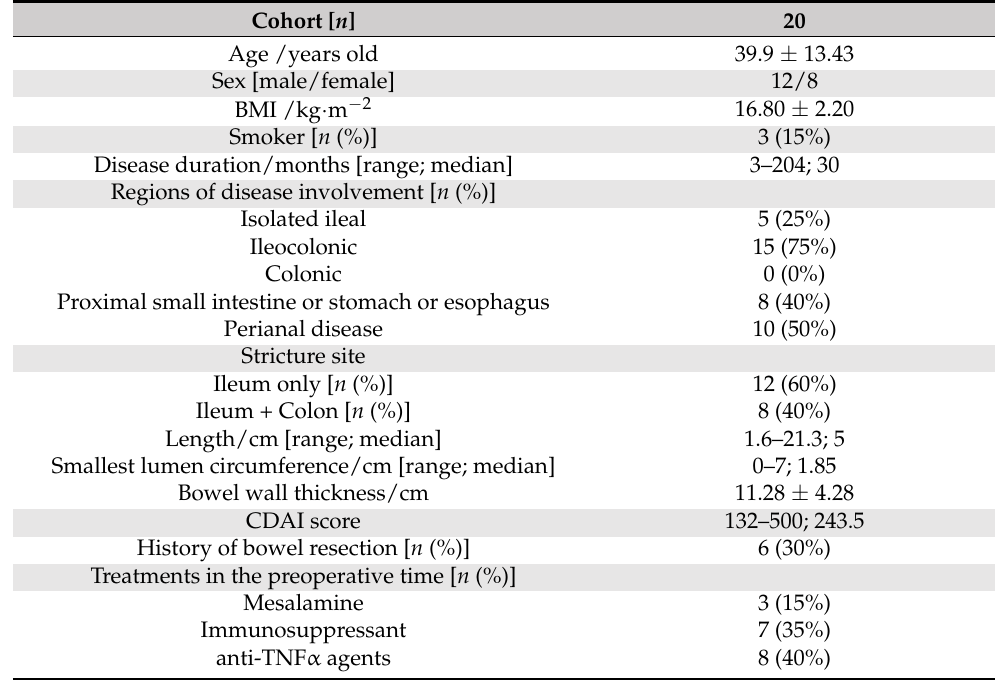
Table 1. Demographics and clinical characteristics of CD